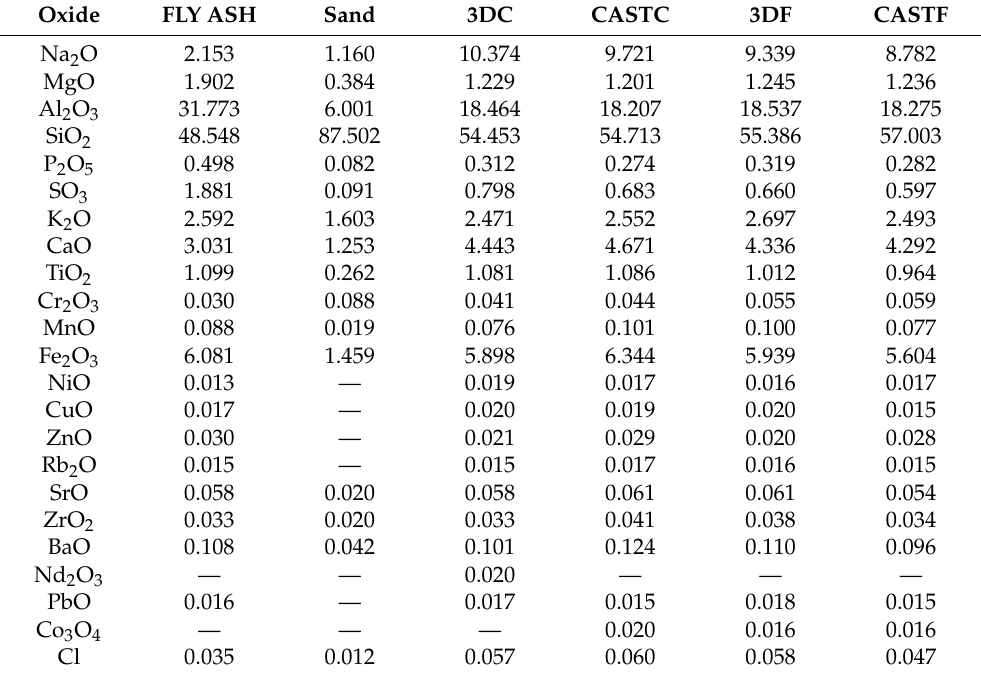
Table 4. The oxide